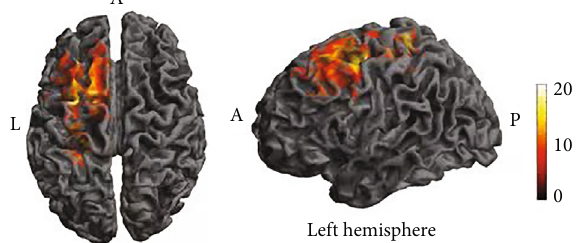
Figure 5: Activated brain regions in the main e ff ect of condition. L: left; A: anterior. The color bar shows the F